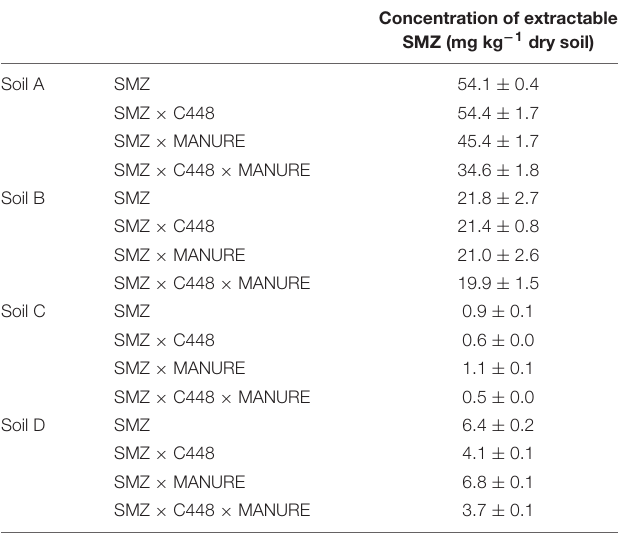
TABLE 1 | Concentrations of extractable SMZ measured after 1 month of incubation in the four different types of soils treated with SMZ, amended or